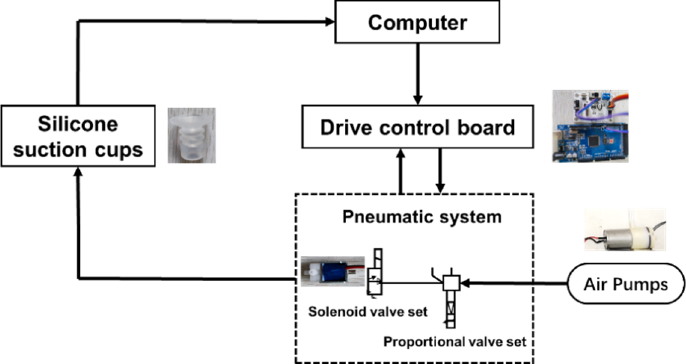
Figure 20. Mechanical hand control